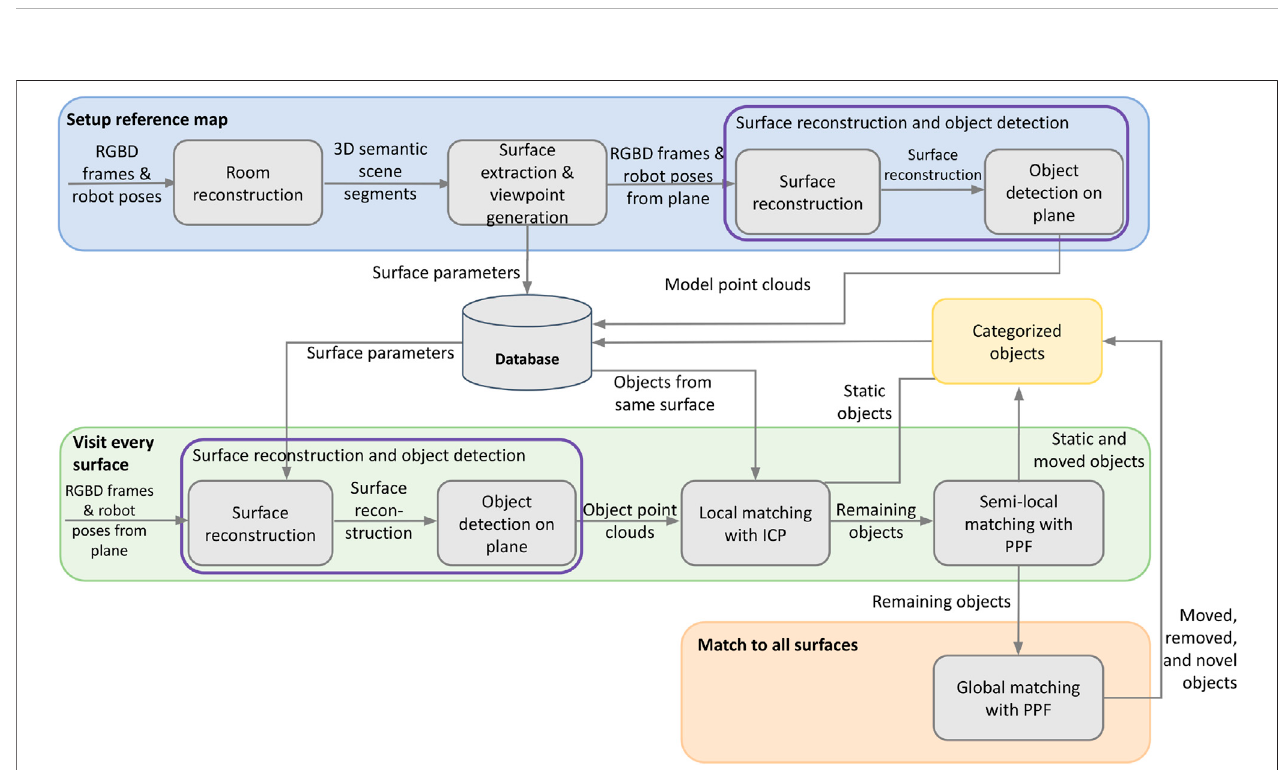
FIGURE 1 | System overview of our approach. The setup of the reference is performed only once.